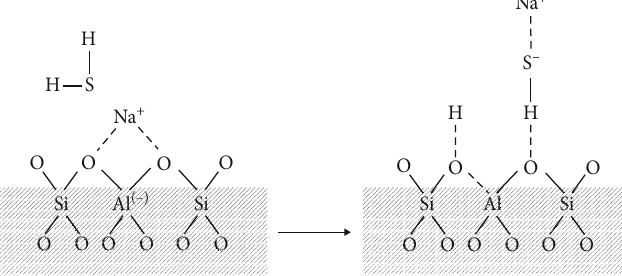
Figure 9: Mechanistic proposal for chemisorptive bonding of H